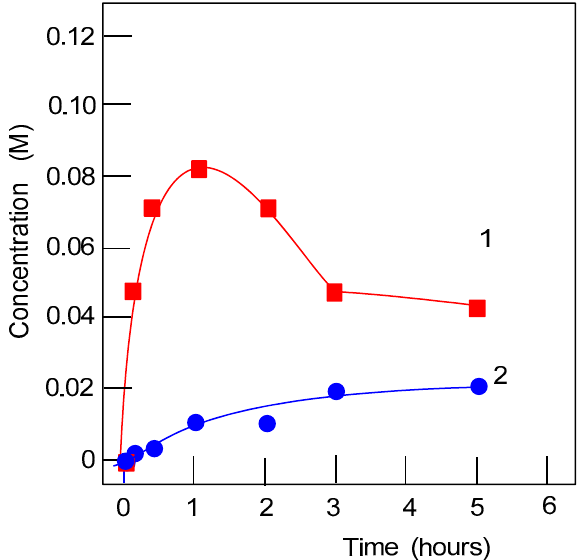
Figure 10. Oxidation of cyclohexane with hydrogen peroxide (50% aqueous;) catalyzed by com- pound 15 in MeCN at 60 °C. Concentrations of cyclohexanone and cyclohexanol were after reduction of the aliquots with solid PPh 3 . Points for cyclohexanol (red) and cyclohexanone (blue) are marked by numbers 1 and 2, respectively. Total yield of products 20% after 1 h, TON = 180. Adapted from [72], Copyright (2020) with permission of Elsevier.